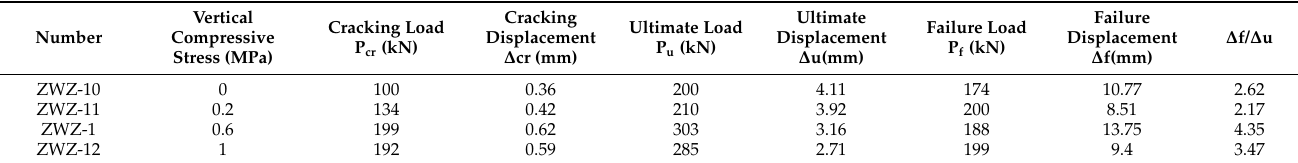
Table 10. Bearing capacity values of the walls with different vertical compressive